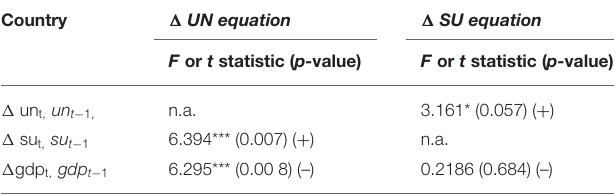
TABLE 5 | Granger-causality analysis based on bootstrap ARDL models. Country